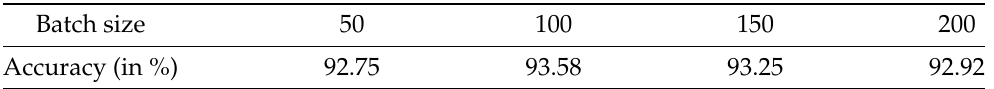
Table 6. Results obtained for different batch sizes keeping image size and epochs at 100 and dropout at 0.5.